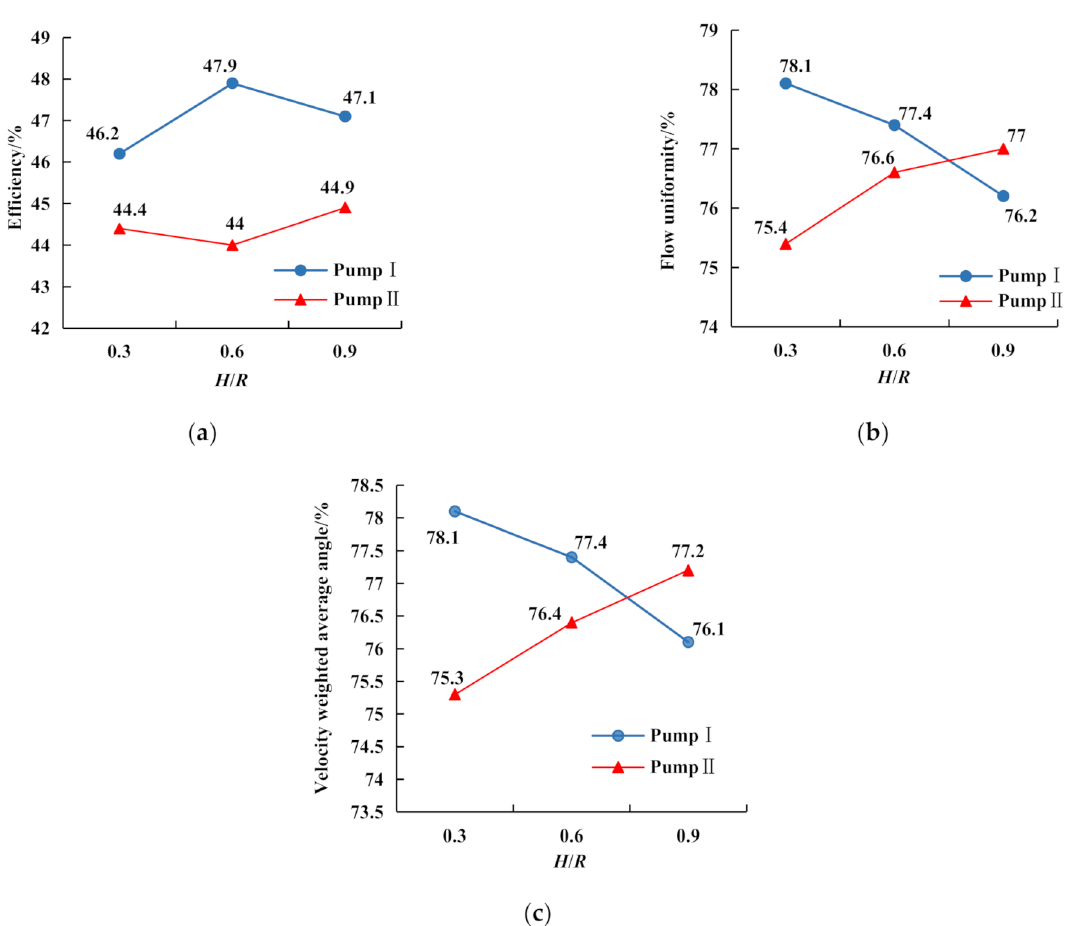
Figure 13. ( a ) The influence of H on the efficiency of the two pumps; ( b ) Variation of the inlet velocity uniformity of the pump impeller chamber with H ; ( c ) The weighted average angle of the inlet velocity of the pump impeller chamber with H